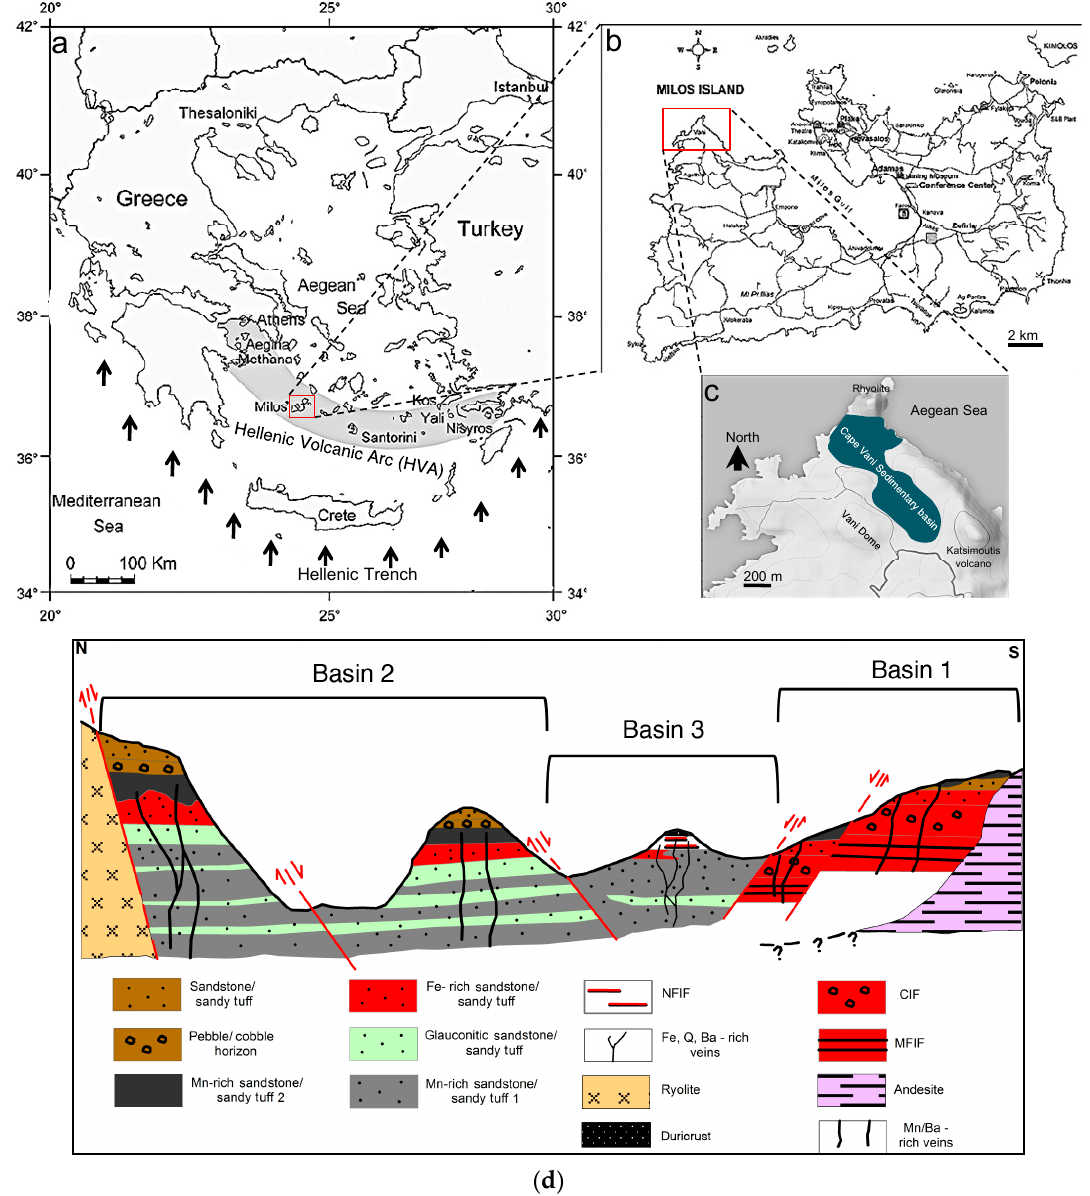
Figure 1. ( a ) The location of Milos Island in the Aegean Sea, showing the Hellenic Volcanic Arc (HVA). Arrows indicate northeast subduction of the African plate underneath the Eurasian plate; ( b ) Milos Island; ( c ) the eight-shaped Cape Vani sedimentary basin (CVSB); ( d ) a generalized north-south stratigraphic map of the ~1 km long Cape Vani sedimentary basin (CVSB) showing interpreted geology, lithology, and main faults. CIF: conglomerate-hosted iron formation; NFIF: non-fossiliferous iron formation; MFIF: microfossiliferous iron formation [50,51].